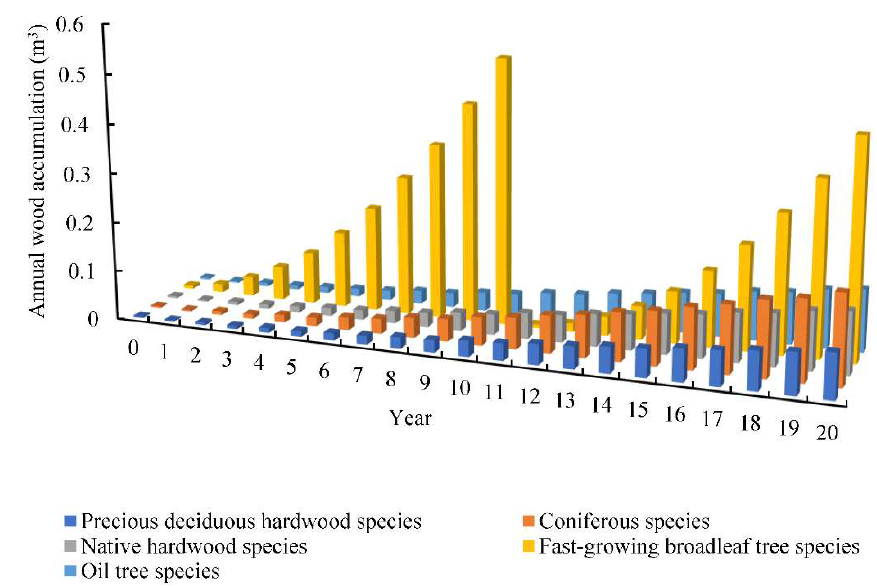
Figure 2. Annual wood accumulation of five tree species in Laohekou NAP.